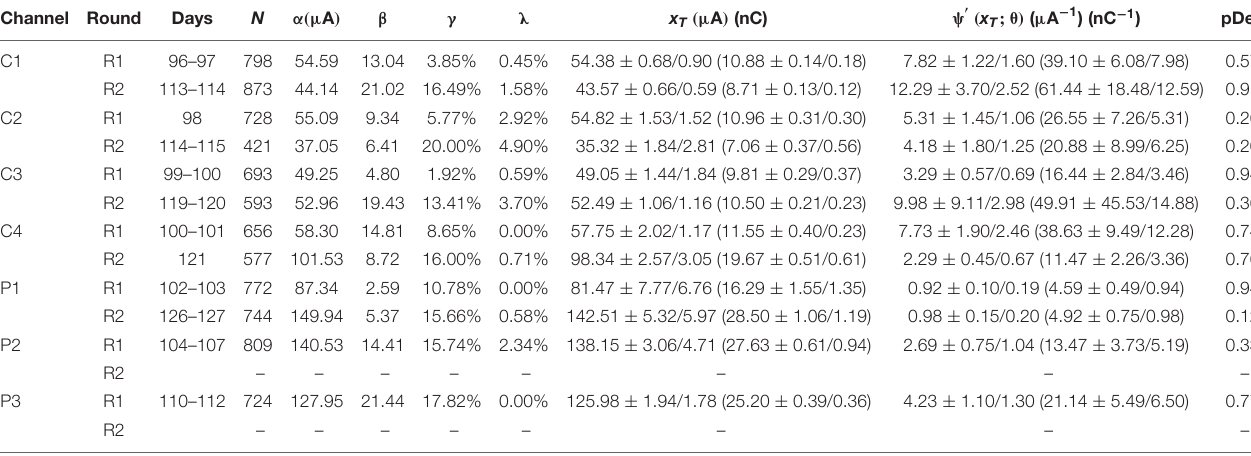
TABLE 4 | Fitted parameters α , β , γ , and λ for psychometric curves generated by single-channel stimulation of channels C1, C2, C3, C4, P1, P2, and P3 in Rat D. Channel